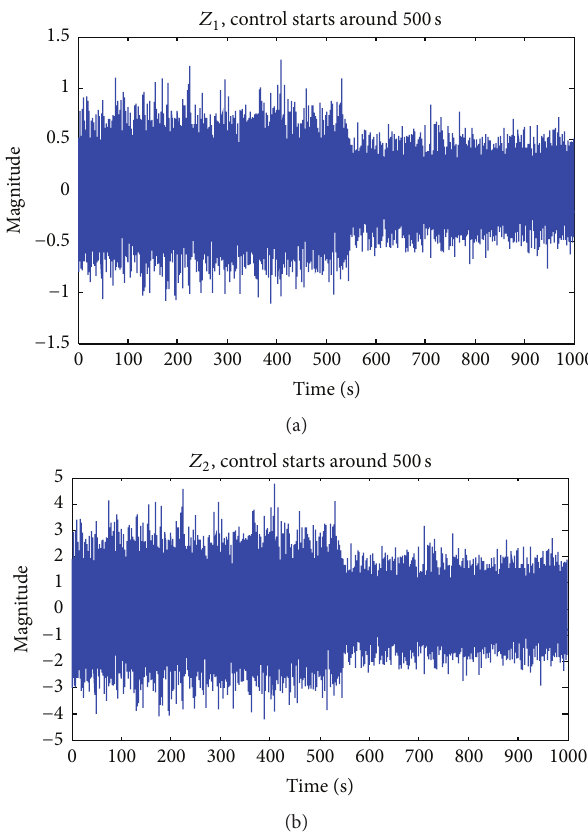
where 𝑘 0 = 30 , 𝐿 = 65 m, 𝐿 1 = 6 m, 𝑎 1 = 0.5 , 𝑎 2 = 0.1 , = 0.2 , and 𝑎 = −0.2 𝑎 3 4